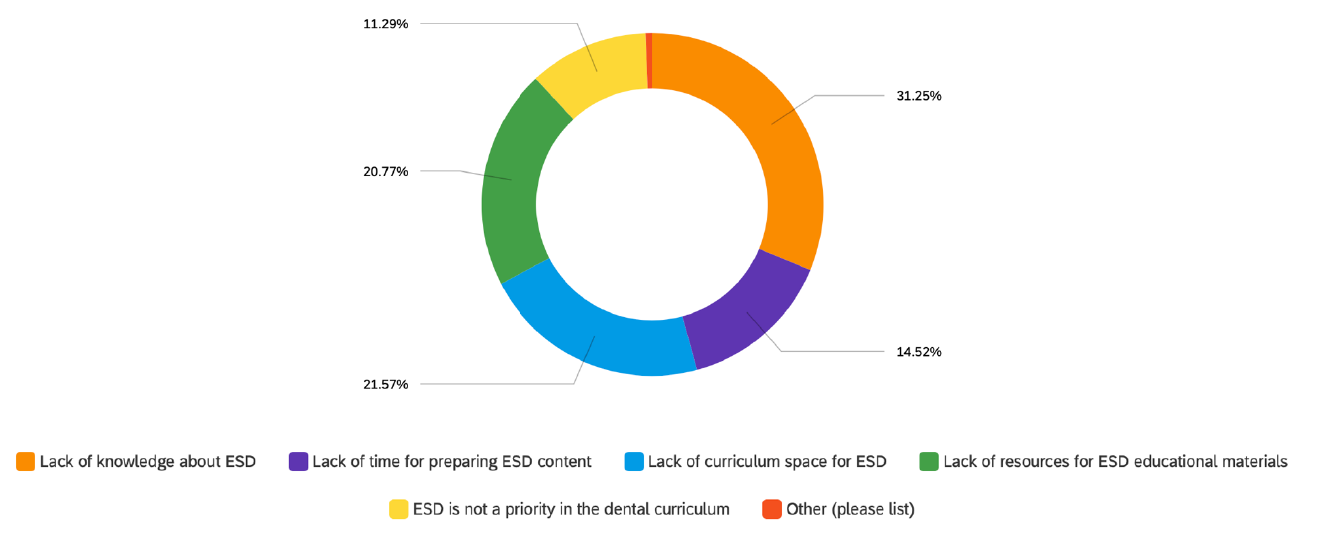
Figure 2. Faculty’s barriers to embedding environmentally sustainable dentistry (ESD) in the dental curricula.